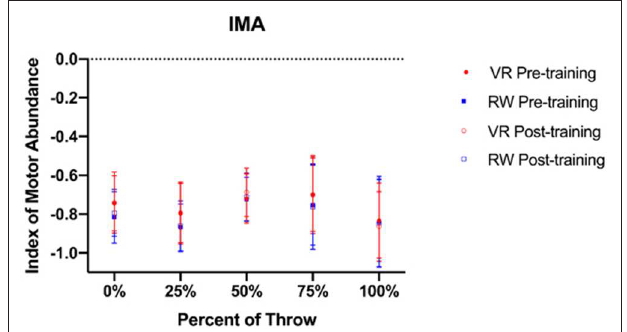
FIGURE 6 | Index of Motor Abundance (IMA) for those trained in virtual reality and the real world before (pre) and after (post) training.